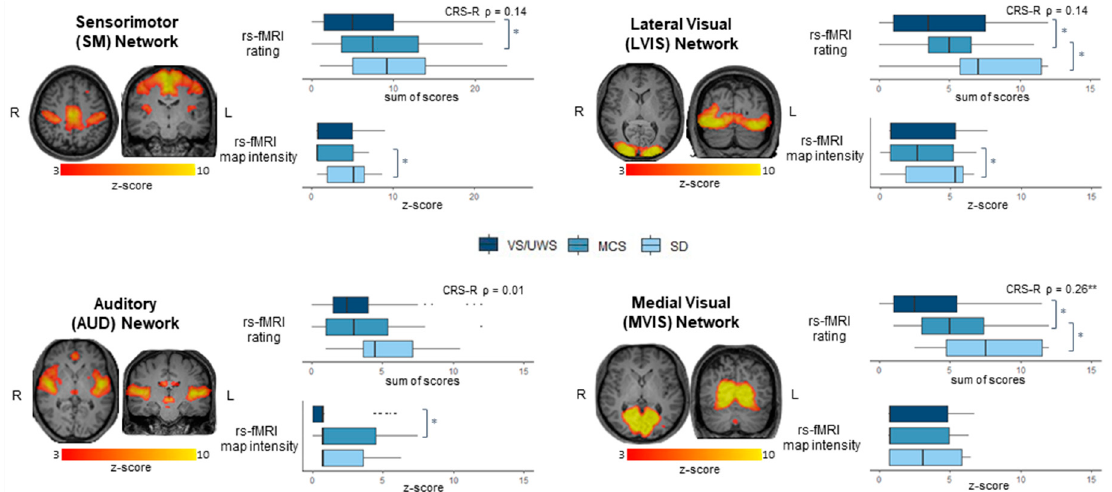
Figure 2. The 4 rs-fMRI networks: sensorimotor (SM), auditory (AUD), lateral visual (LVIS) and medial visual (MVIS) networks. For each network, on the left, the spatial map generated from the group-level ICA on control subjects; on the right, group differences measured with rs-fMRI rating and rs-fMRI map intensity between VS/UWS, MCS and SD patients. Boxplot with medians and interquartile range are reported, with Mann–Whitney Z scores. For each network the correlation of rs-fMRI rating with CRS-R total score is reported. * p < 0.05; ** p < 0.01.